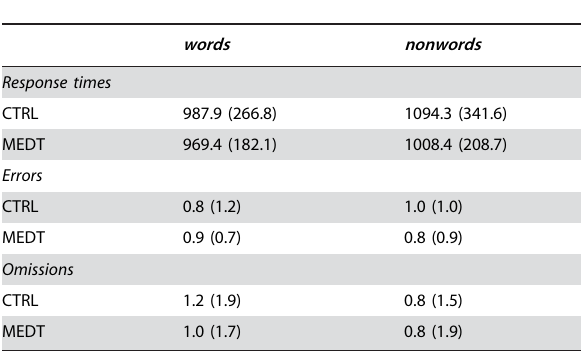
Table 1. Behavioral data for the lexical decision task: mean response times (in ms, st. dev. in parentheses), mean number of errors, and omissions (st. dev. in